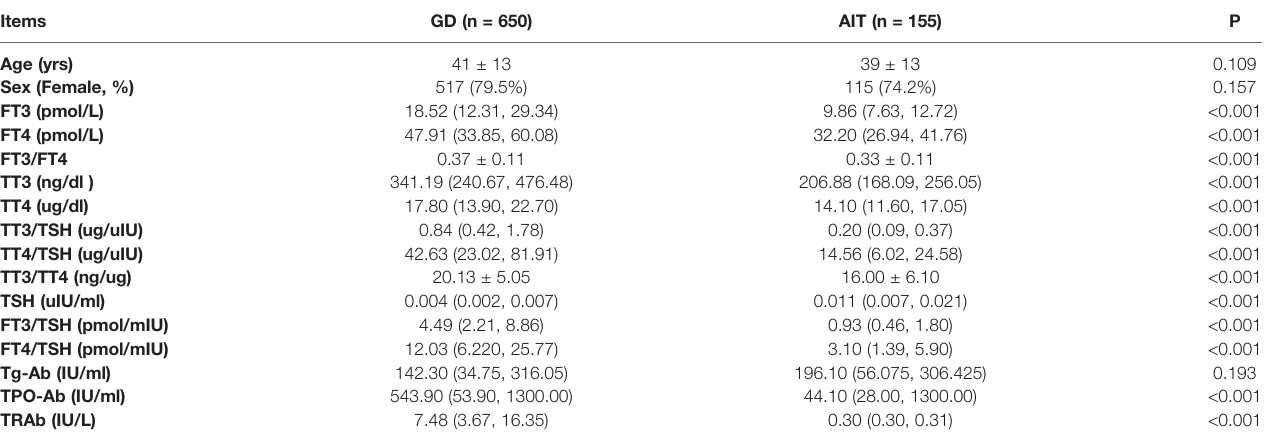
TABLE 1 | Clinical characteristics of patients with Graves ’ disease and those with autoimmune thyroiditis in Cohort 1.